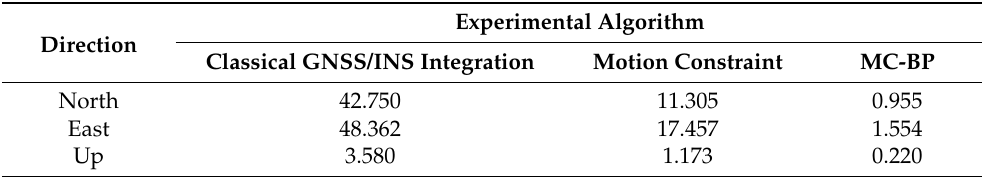
Table 4. RMS values of positioning errors for vehicle land experiment (m).